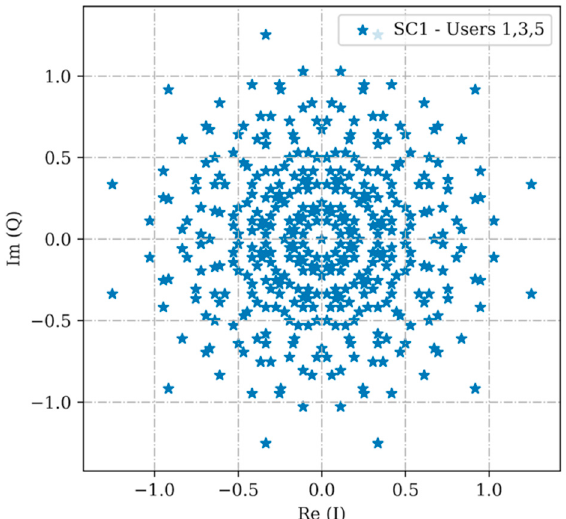
Figure 2. Subcarrier 1 IQ constellation.